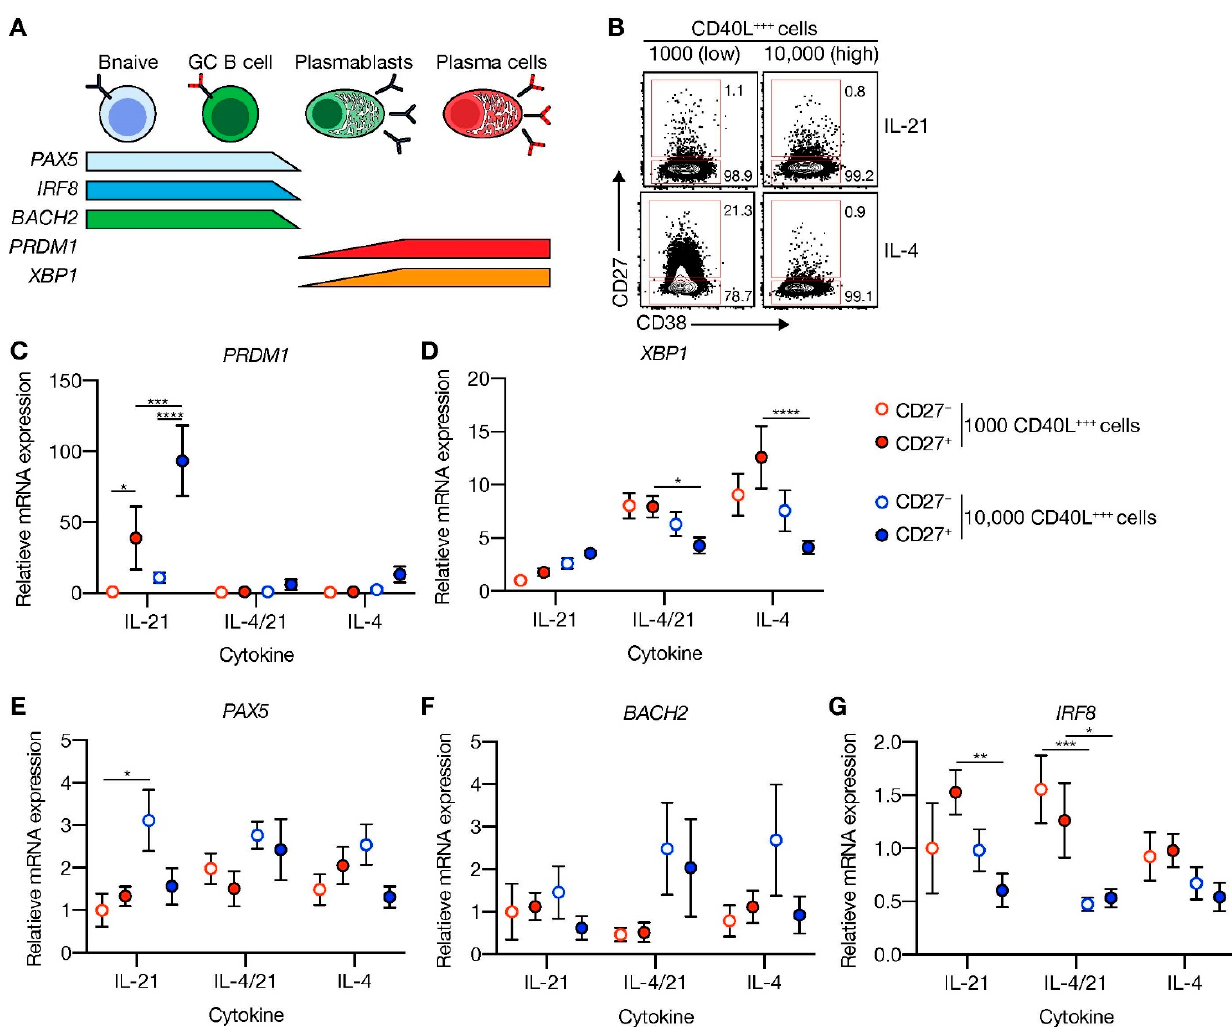
Figure 3. CD40 costimulation together with IL-21 signaling induces PRDM1 expression and does not extinguish the B-cell lineage transcriptional program. ( A ) Schematic overview of the cellular stages and important transcription factors involved in B-cells differentiation from naive to antibody-secreting plasma cell (GC = germinal center). ( B ) Representative plots of human naive B-cells cultured on 1000 (low; supplemented with 9000 WT 3T3 cells) or 10,000 (high) CD40L +++ -expressing 3T3 cells (as in Figure 1A) with or without IL-21 and/or IL-4 for 9 days. Subsequently, CD27 − CD38 − (CD27 − ) and CD27 + CD38 − (CD27 + ) cells were purified by cell sorting. ( C – G ) Expression of PRMD1 ( C ), XBP1 ( D ), PAX5 ( E ), BACH2 ( F ) and IRF8 ( G ) mRNA in the sorted populations were analyzed by qPCR and related to levels present in the CD27 − cells that were cultured on 1000 (low) CD40L +++ -expressing 3T3 cells together with IL-21. Data are shown as mean ± SEM. ( n = 5 independent experiments). Single experiments were conducted in triplicate. Data were analyzed by a two-way ANOVA followed by Tukey’s multiple comparison test. * P ≤ 0.05, ** P ≤ 0.01, *** P ≤ 0.001, **** P ≤ 0.0001.